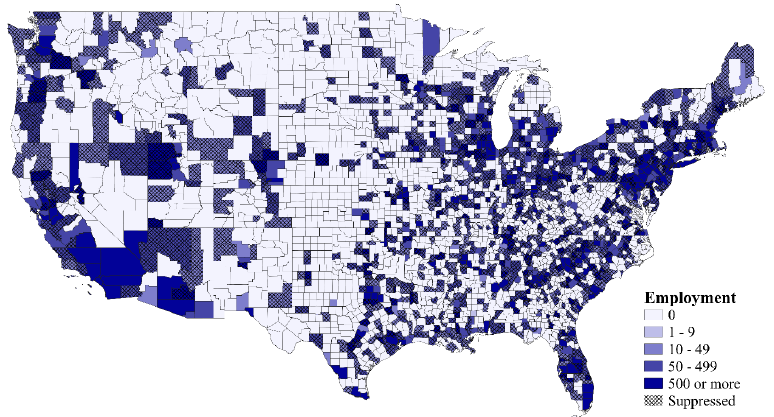
Figure A.4: Employment Distribution of General Warehousing & Storage (NAICS 493110)